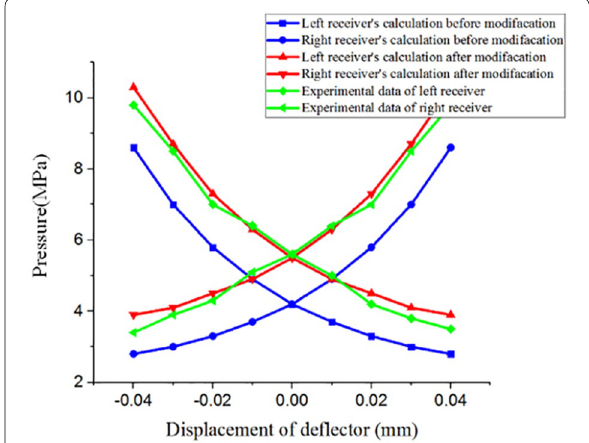
Figure 25 Comparison of the pressure characteristics